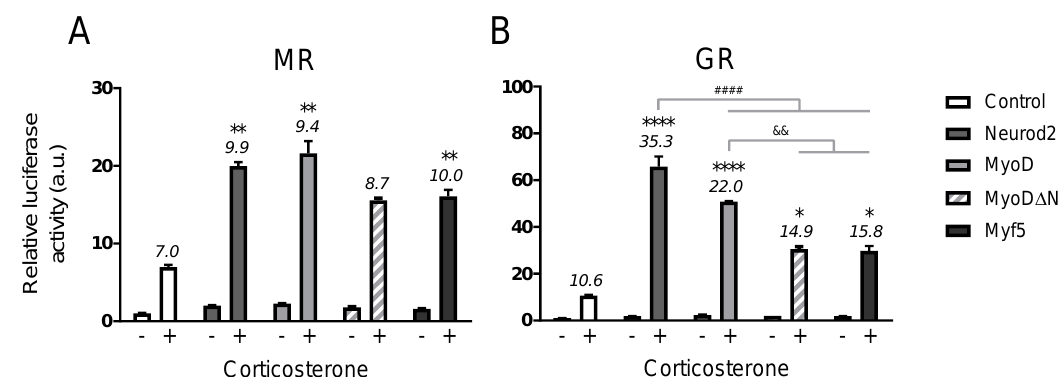
Figure 3. Modulation by NeuroD and MyoD variants at the shared binding motif (CAGCTG) for ( A ) MR- and ( B ) GR-mediated transcription. HEK293 cells were transfected with GRE-At_GC luciferase construct, MR or GR (10 ng/well), and Neurod2, MyoD, MyoD ∆ N or Myf5 (10 ng/well), and stimulated with corticosterone (10 − 7 M). Luciferase activity of nonstimulated control cells was normalized to 1. Numbers represent fold induction upon corticosterone treatment. a.u. = arbitrary unit; * p < 0.05, ** p < 0.01, **** p < 0.0001 compared to control condition; #### p < 0.0001 compared to Neurod2 condition; && p < 0.01 compared to MyoD condition